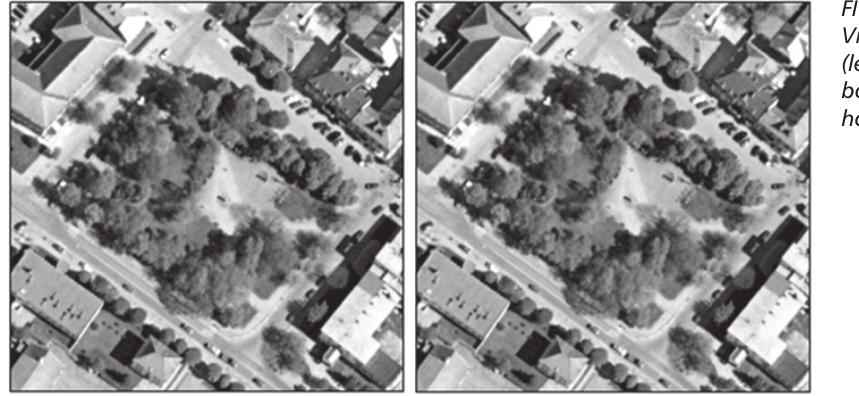
Visible square boundaries (left) and non-visible boundaries (right) of housing block